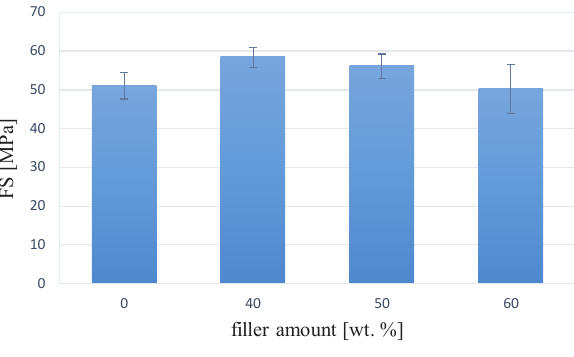
Figure 2: The infl uence of filler amount on Young’s modulus (E) of neat resin and composite filled with 40, 50 or 60 wt. % silanized silica; photopolymerization conditions - 20 second/1 mm material thickness, the power of light curing unit 1400 mW/cm 2 .